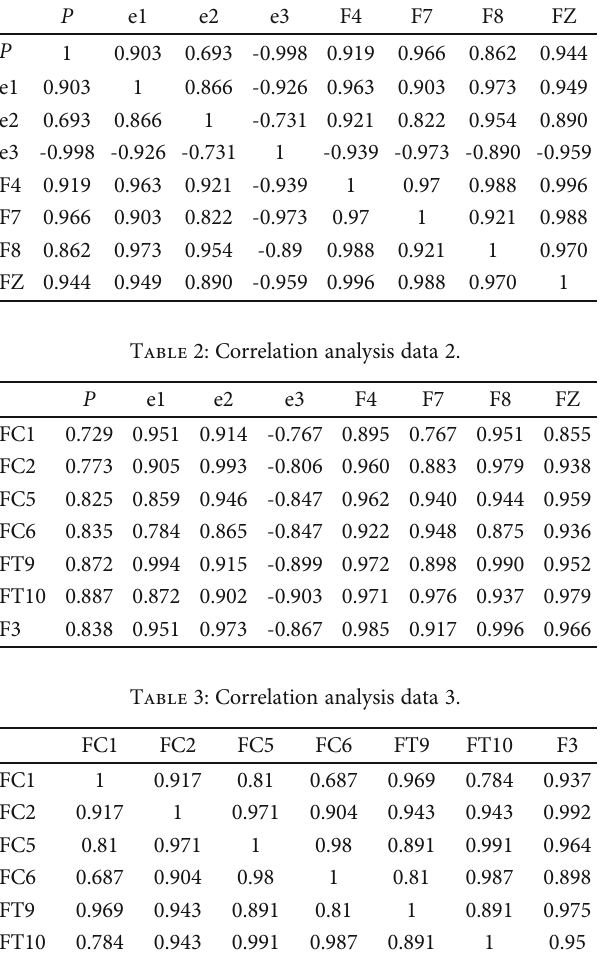
analysis. We assume that the reader is familiar with the basic